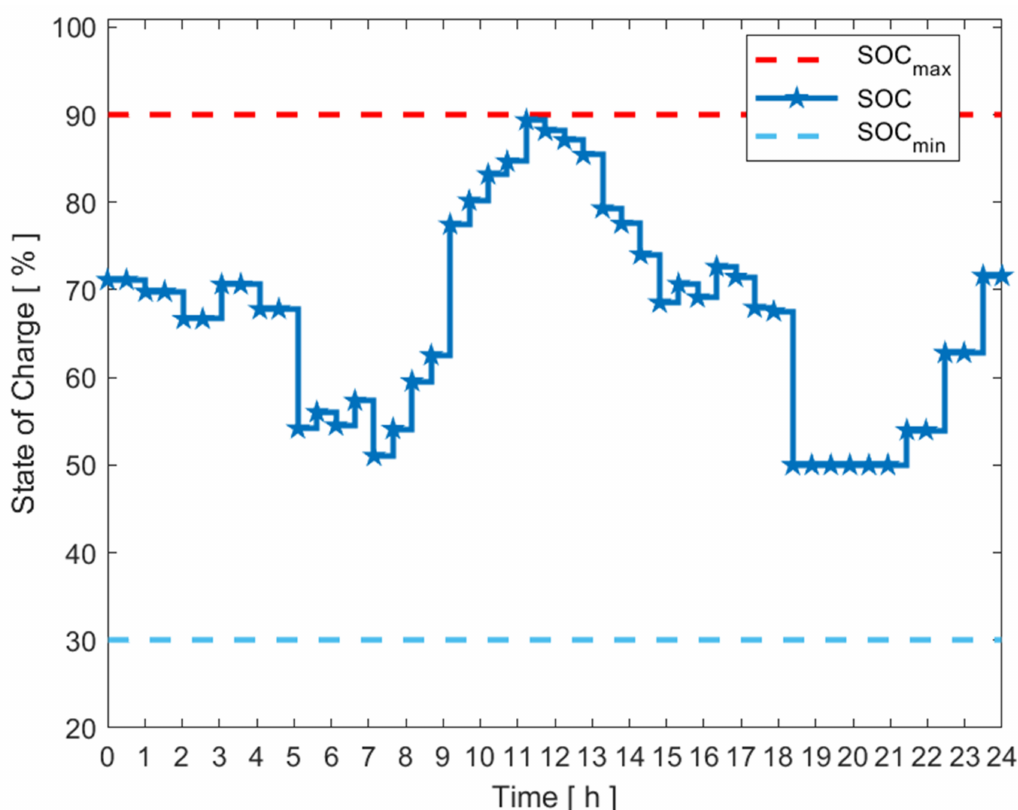
Figure 12. State of energy of the BSS for the DES